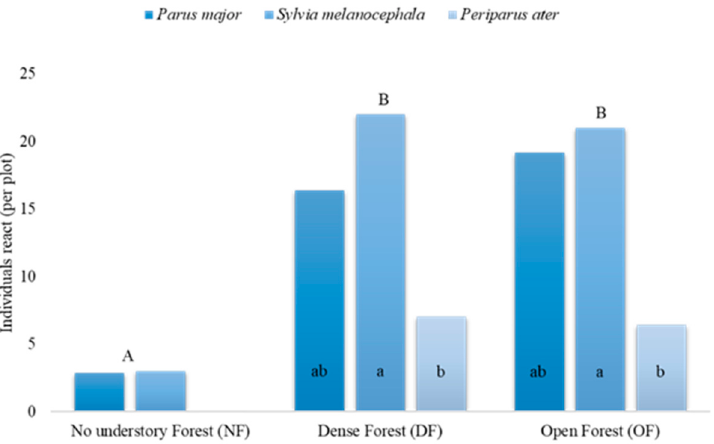
Figure 2. Total number of birds (pooled across all species) responding to alarm calls of three bird species ( F = 9.41, df = 2, 106, p < 0.001, pooled across seasons) in three types of pine forest habitat ( F = 6.61, df = 2, 106, p < 0.001, pooled across seasons). Capital letters above bars represent significant ( p < 0.05) difference between the three forest types. Small letters within bars indicate significant ( p < 0.05) differences between three caller species within habitat types (Bonferroni multiple comparisons).